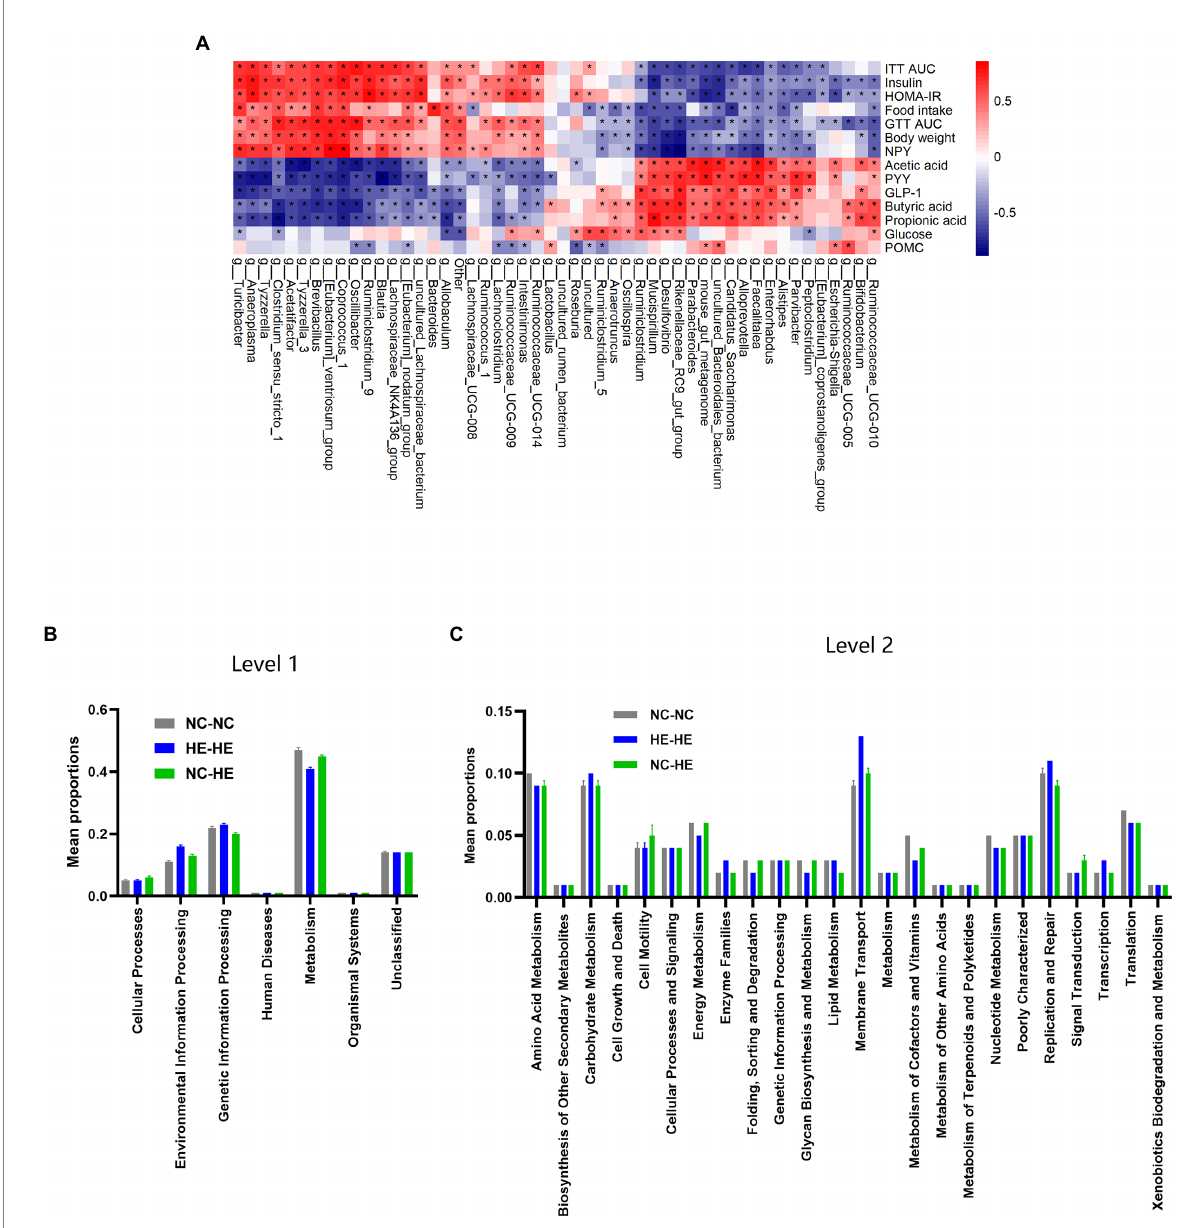
FIGURE 5 Correlation analysis between gut bacterial genera and metabolic indices. (A) Heatmap of Spearman correlation analysis between the top 50 differentiated genera and metabolic indices. The degree of correlation is shown by a gradient from red (positive correlation) to blue (negative correlation); asterisks indicate p < 0.05. (B,C) KEGG pathway prediction of genera at levels 1 (B) and 2 (C) by PICRUSt2